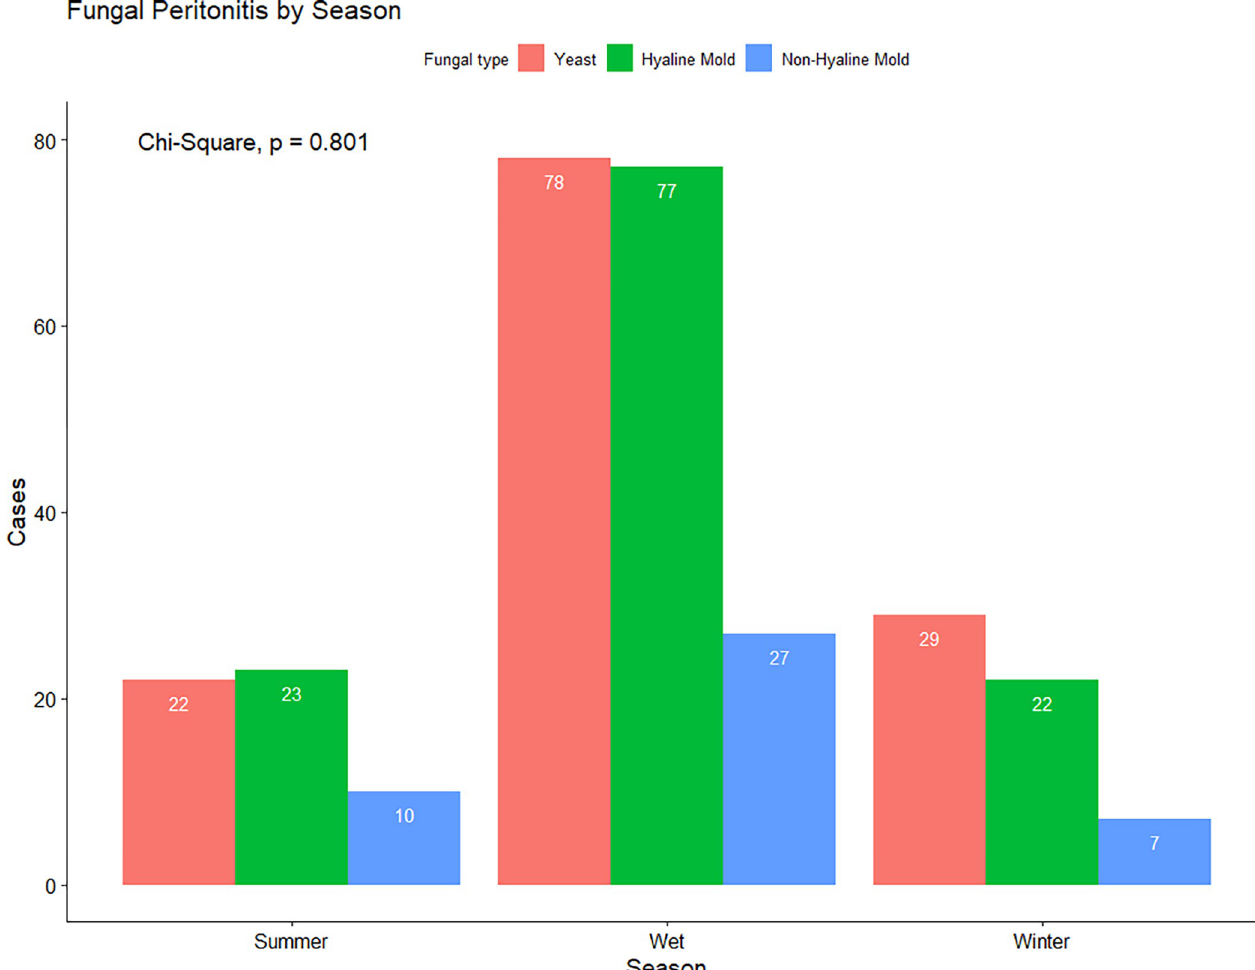
Fig 2. Seasonal variation in the prevalence of fungal peritonitis episode according to fungal type by wet smear.